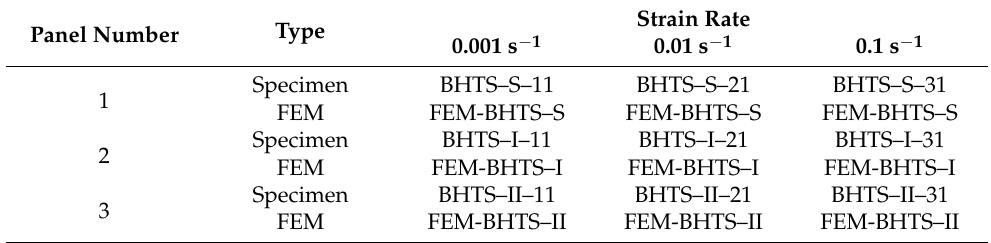
Table 4. BHTS test set and FEM